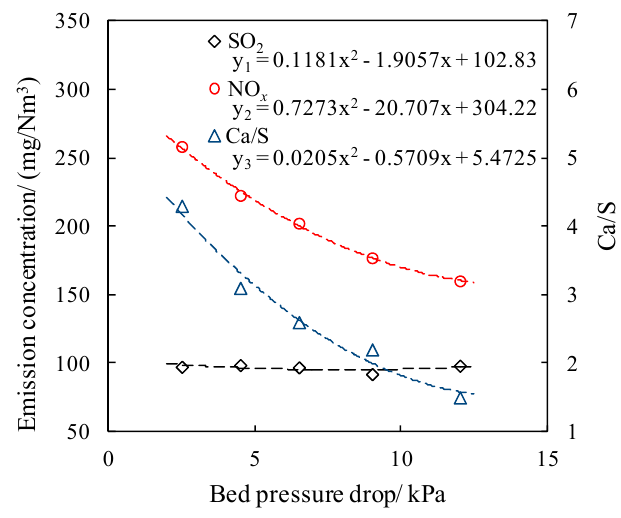
Figure 14. SO 2 and NO x emission under different bed pressure drop.